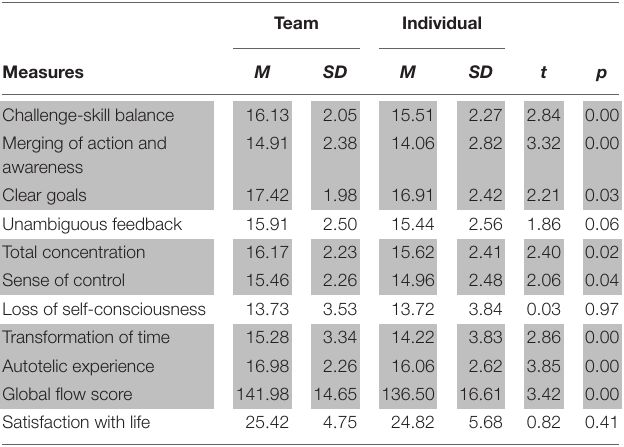
TABLE 2 | Comparison of team and individual performers in flow dimensions and satisfaction with life. Team Individual